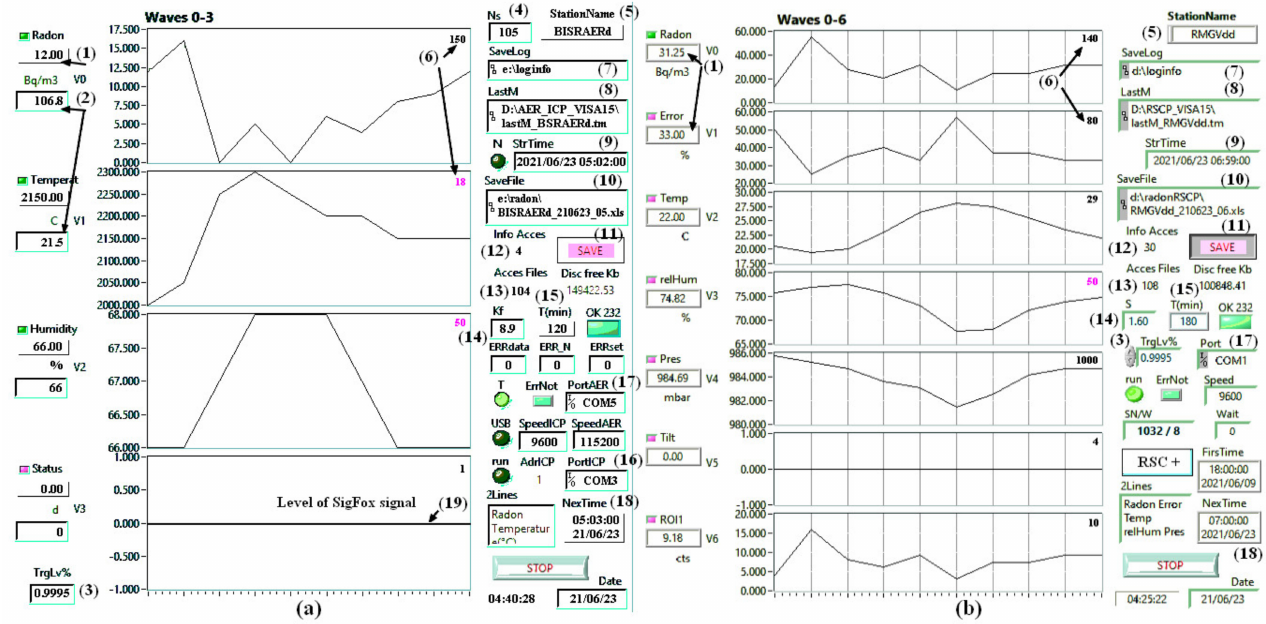
Figure 5. Panels for radon data acquisition. ( a ) Software for AER +C; ( b ) Software for Radon